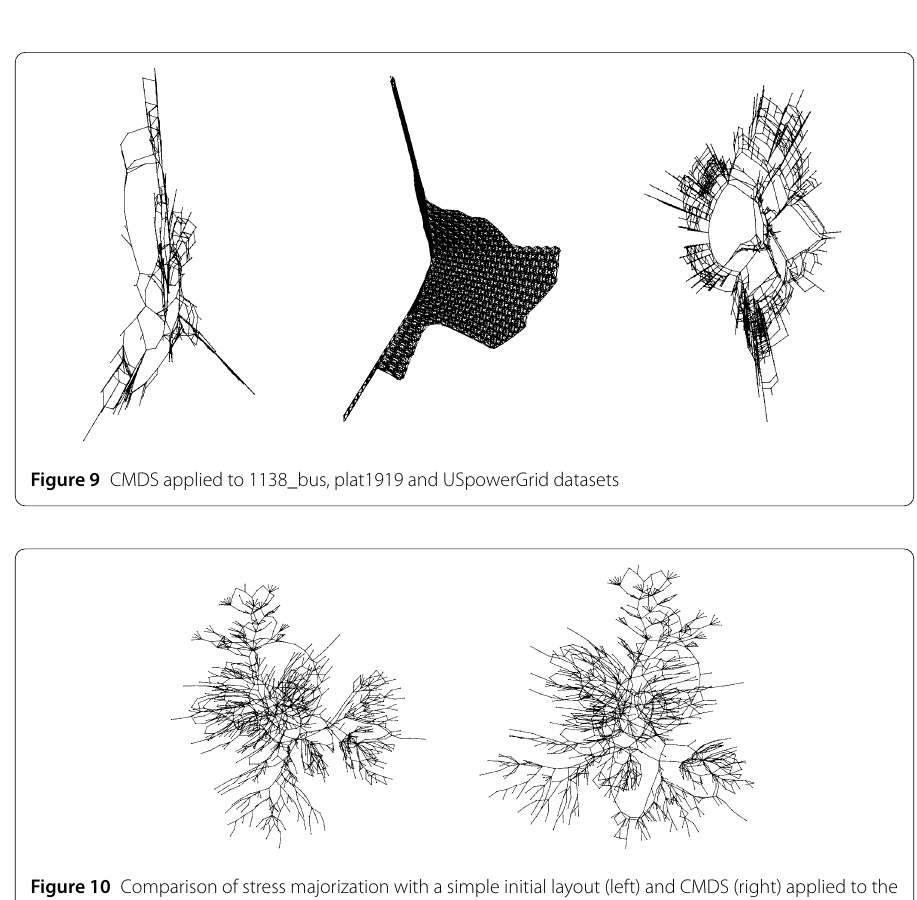
Figure 10 Comparison of stress majorization with a simple initial layout (left) and CMDS (right) applied to the 1138_bus